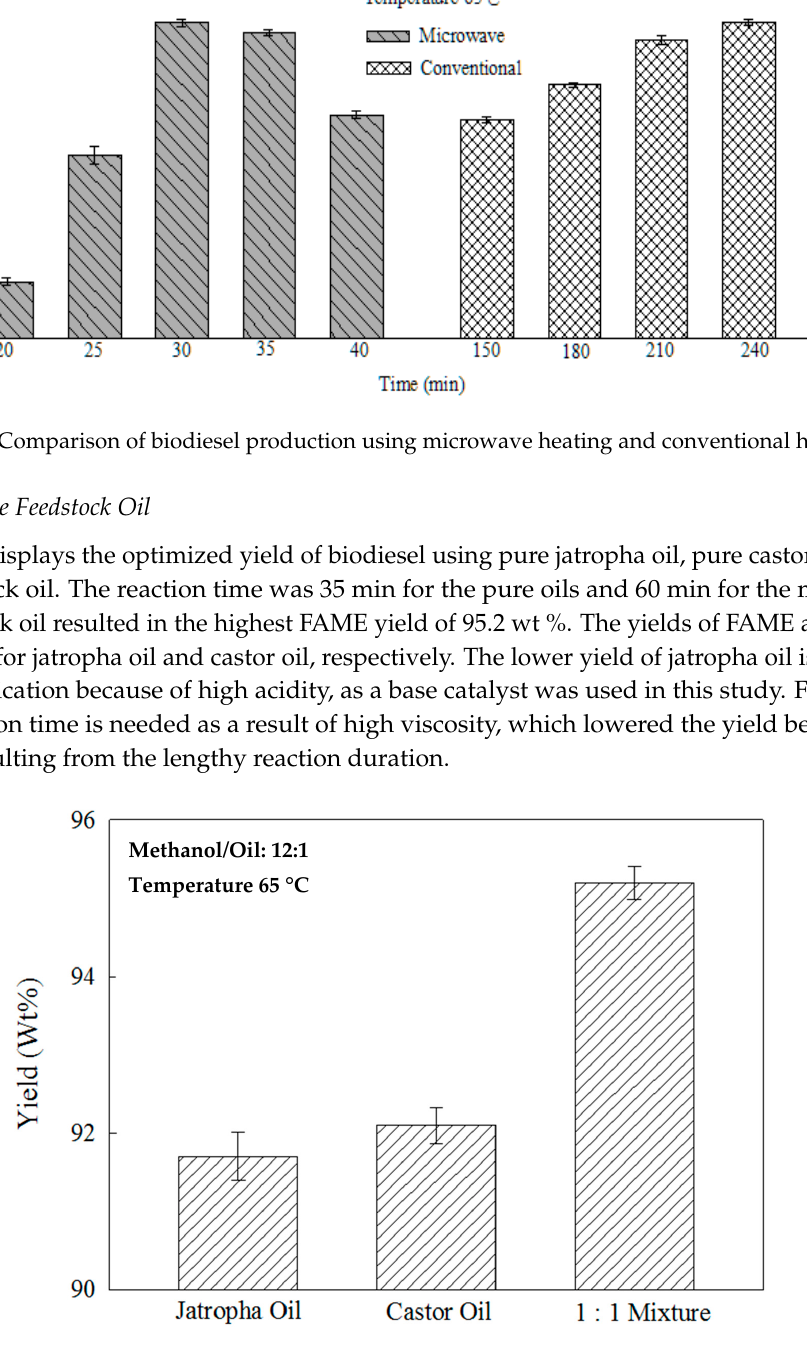
Figure 9. Effect of the feedstock oil on the yield of biodiesel with microwave heating.